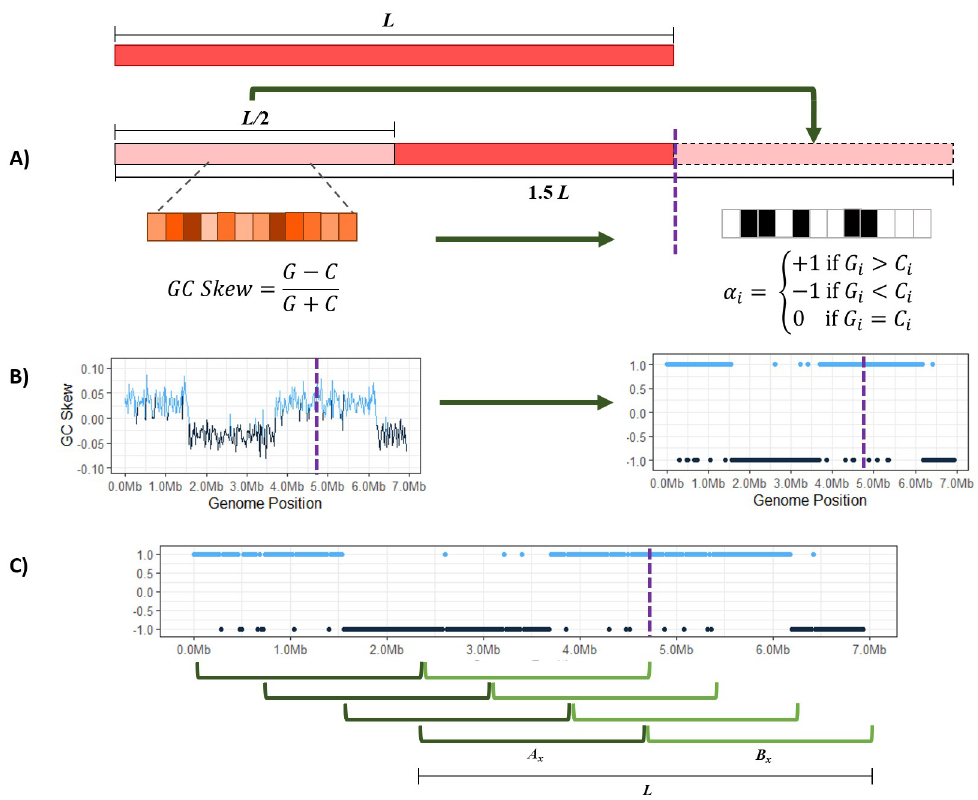
Fig 1. The SkewIT algorithm. A genome of length L is“circularized” by taking the first half of the sequence (L/2) and concatenating that sequence onto the end of the genome (A). The algorithm then splits the sequence into many shorter windows of length w . We assign each window an α value [1,-1,0] based on whether there are more Gs, Cs, or equal quantities of both. (B) The GC skew statistic is shown (left) plotted across the E. coli genome, with a purple dotted line showing where the original sequence ended, prior to concatenating 1/2 of the genome to the end. The plot on the right shows the α value plotted for the same genome. (C) SkewIT finds the location in the genome with the greatest difference in GC skew between the first half and the second half of the genome, by using a pair of sliding windows to find the greatest sum of differences between the α values for the two halves.